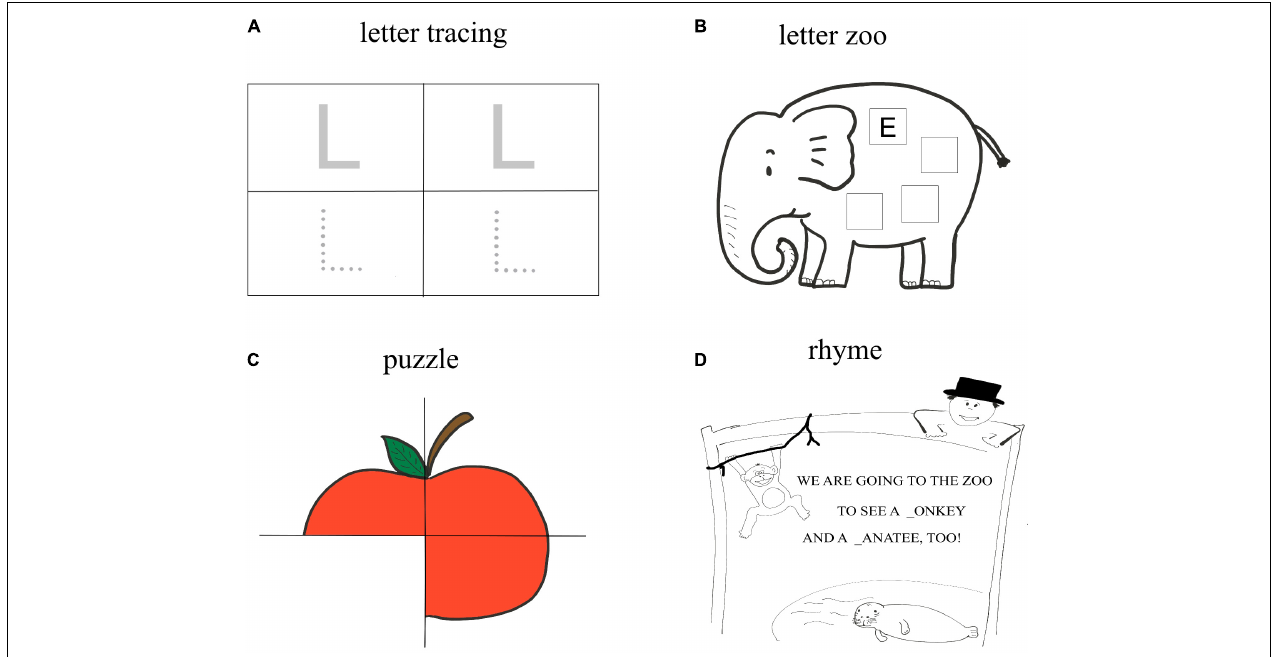
FIGURE 2 | Overview of the training task used for written language training in kindergarten children. The tasks were the same for all three trainings groups (pencil group, stylus group and keyboard group). They differed only with regard to the writing mode (writing with a pencil on a paper vs. writing with a stylus in the tablet surface vs. typing on a digital keyboard). Top left (A) = letter tracing. Top right (B) = letter zoo. Bottom left (C) = puzzle. Bottom right (D) = rhyme completion.